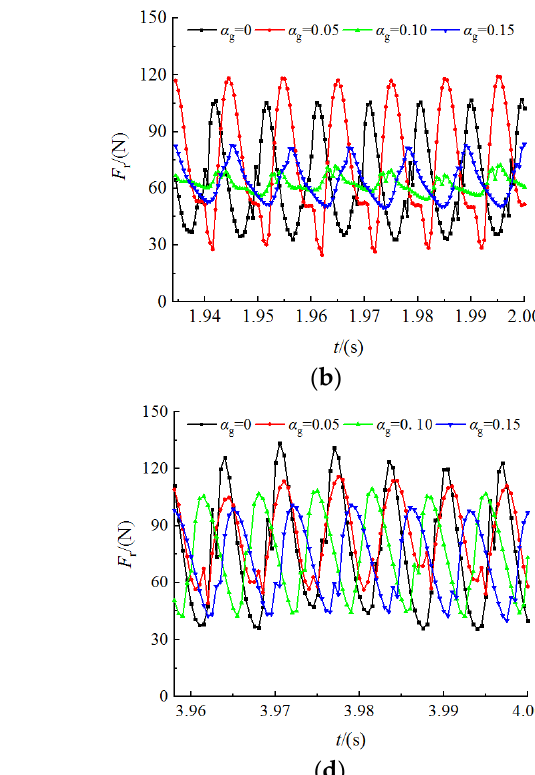
g = 0 and α g = 0.05 is much larger than that under α g =